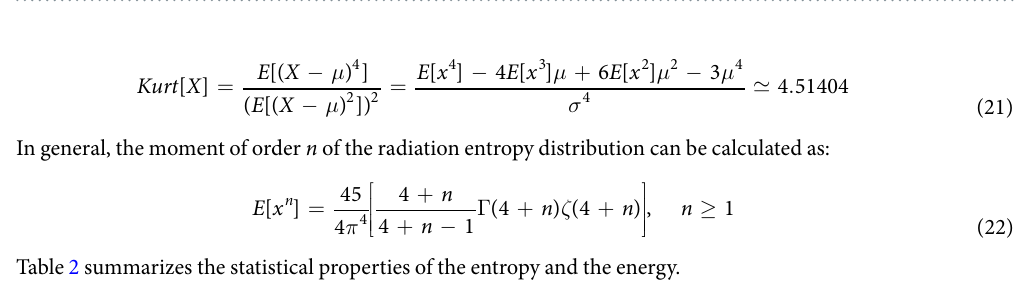
Table 2. Statistical description of the energy and the entropy of radiation in x and in the λ T variable ( × 10 6 nm